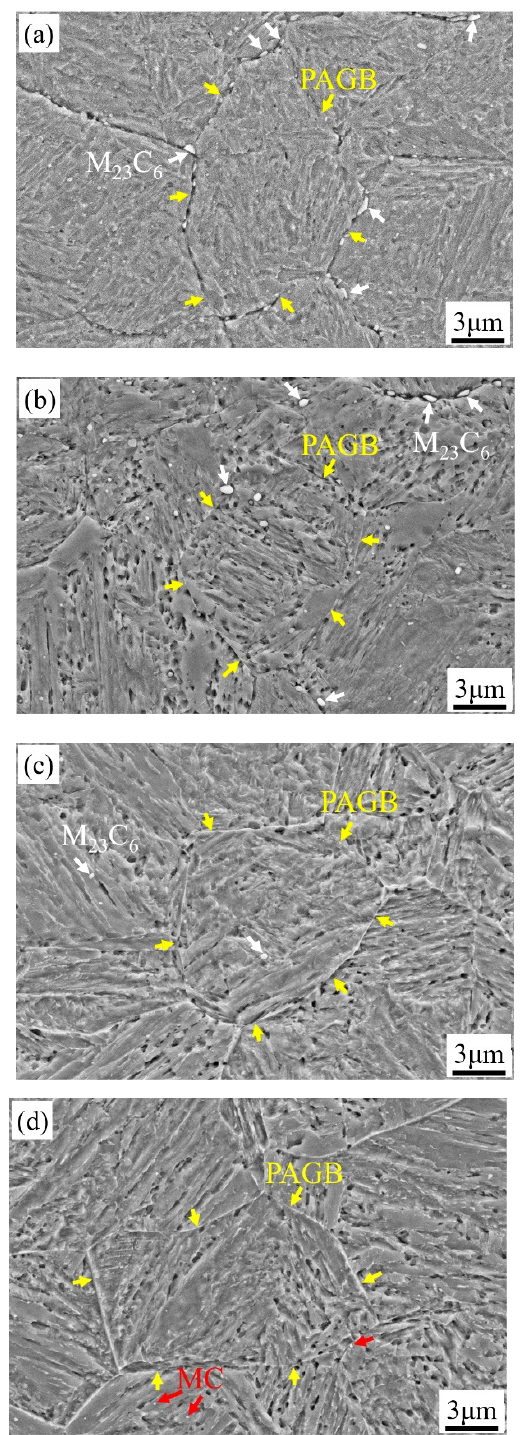
Figure 4. SEM images of ( a ) 1000-P; ( b ) 1020-P; ( c ) 1040-P; ( d ) 1060-P (white, red and yellow arrows represent the M 23 C 6 carbides, MC carbides and the prior austenite grain boundary (PAGB), respectively).